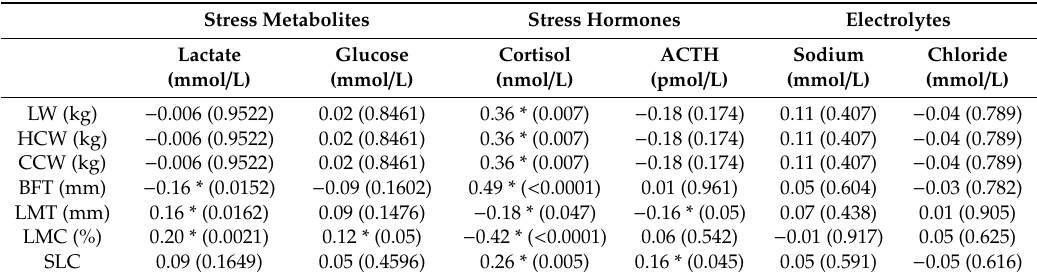
Table 2. Correlations (r) between stress metabolites, stress hormones, electrolytes, and carcass quality traits in slaughter pigs.